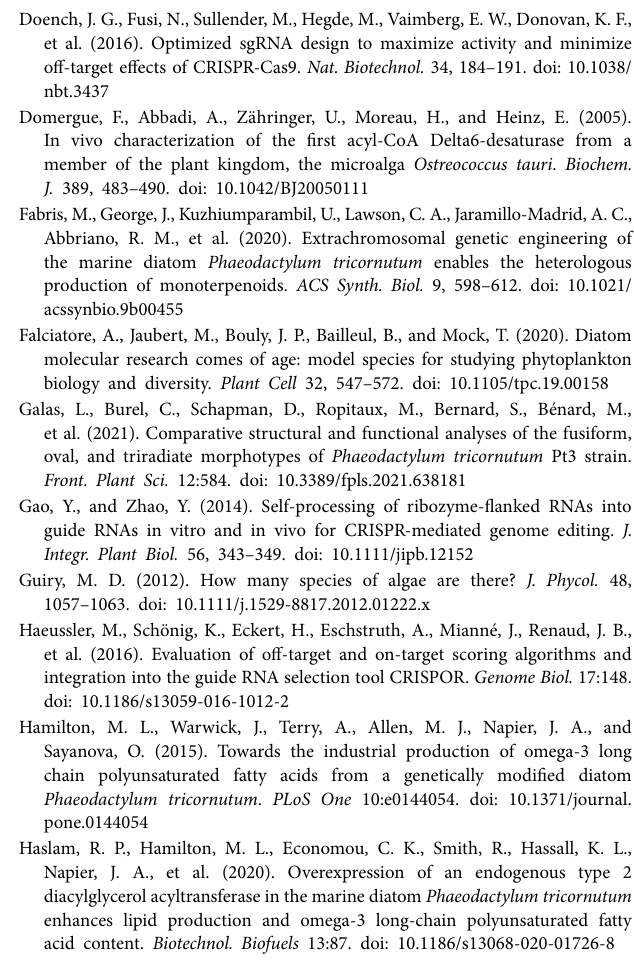
Figure 2D . Supplementary Figure 2 | Wt StLDP gene, amplified with INF-StLDP-F and INF-StLDP-R primers (Materials and Methods), produces a 1,400-bp product; the amplicon of ~700 bp in StLDP-KO (3) indicates a deletion resulting from the multiplexed targeting of all four sgRNA. The positions of DNA size markers are